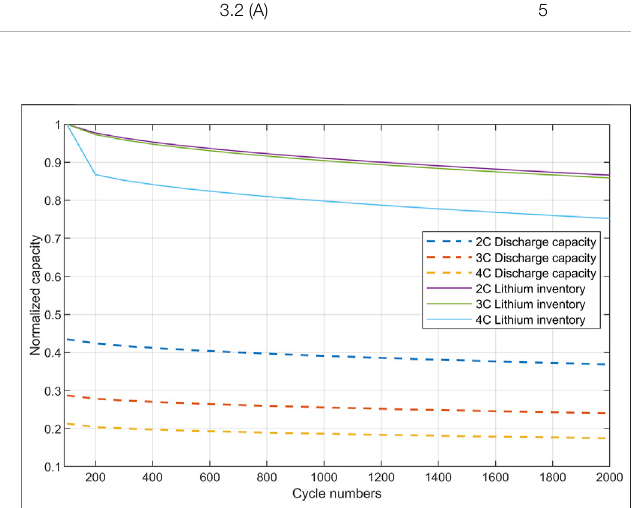
FIGURE 3 | In fl uence of charge rate on charging capacity and available lithium-ion decrease.